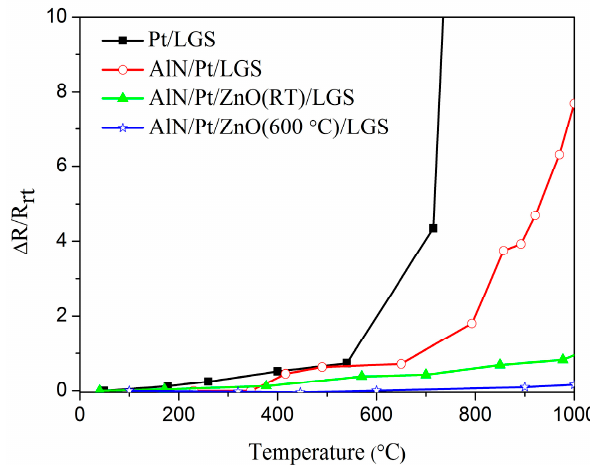
Figure 1. Relative resistance change for different samples as a function of temperature. The AlN/Pt/ZnO(RT)/LGS and AlN/Pt/ZnO(600 °C)/LGS samples correspond to the AlN/Pt/ZnO/LGS samples where the ZnO film was deposited at room temperature and 600 °C, respectively.